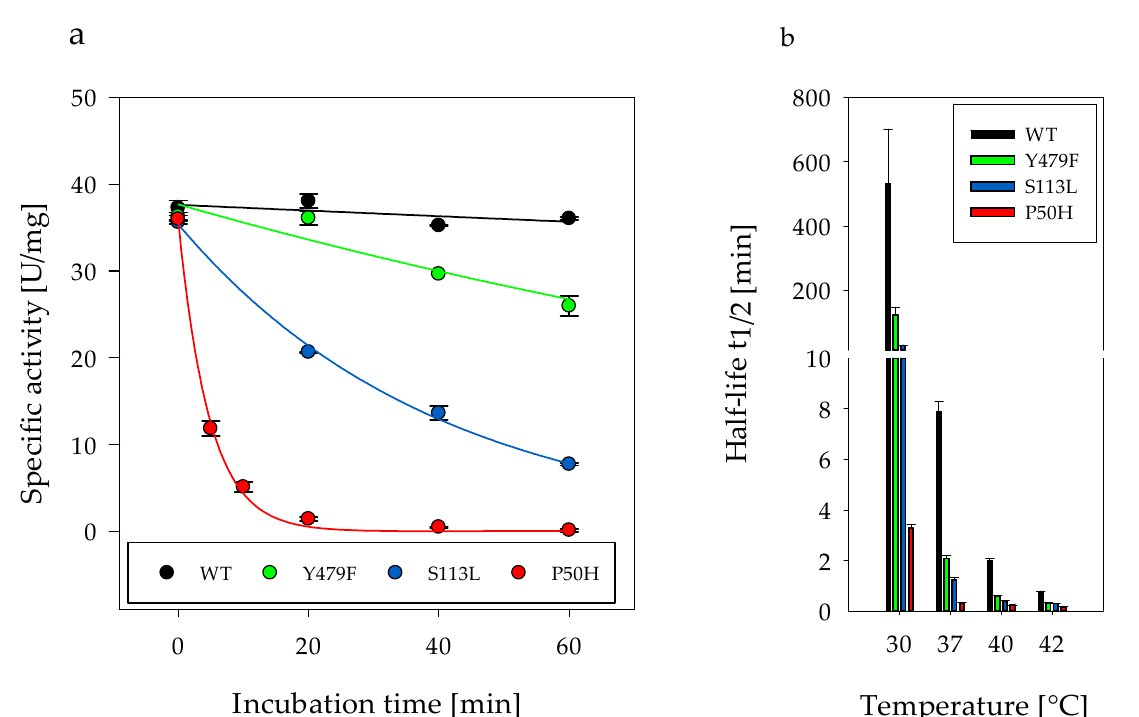
Figure 2. ( a ) Specific activity of recombinant CPT II wild type and variants (enzyme concentration 1 mg/mL during incubation time) at 30 ◦ C measured spectroscopically using enzyme assay. The reaction was started by adding 15 nM enzyme. ( b ) Half-lives of wild type and variants (1 mg/mL) at different temperatures. Error bars are standard deviation (SD) derived from three independent experiments. The statistical differences of the half-lives between WT and the variants and between the different temperatures are given as p -values in Tables S1 and S2.